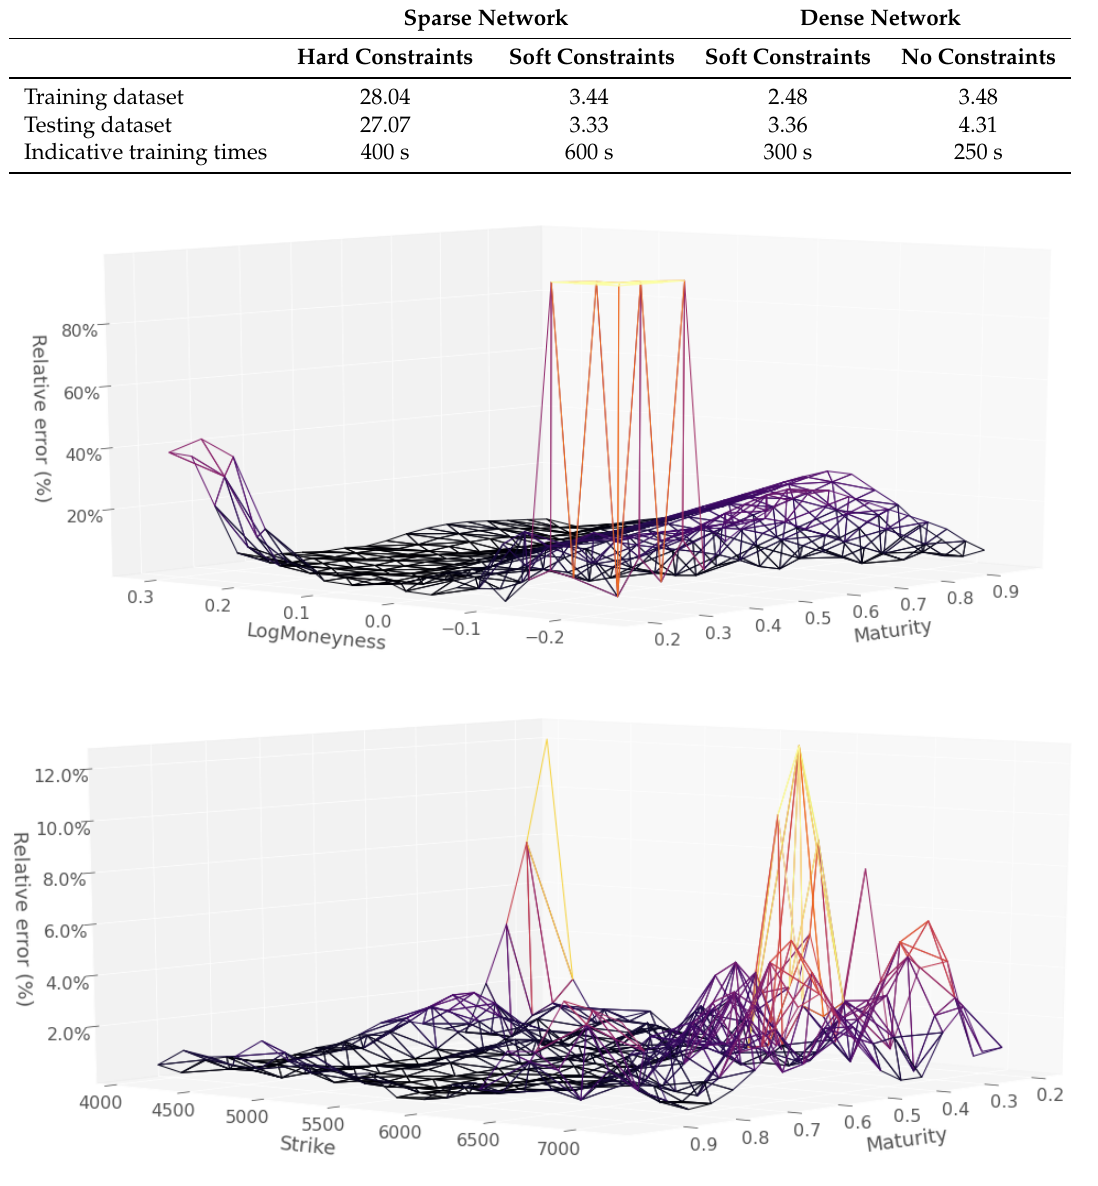
Figure 5. Percentage relative error in the implied volatilities using ( top ) hard constraints ( bottom ) dense networks with soft